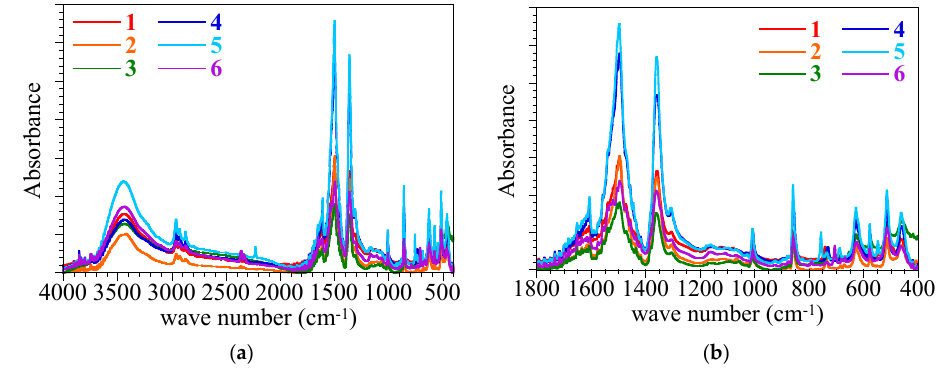
Figure 2. ( a ) Absorbance FT-IR spectra of compounds 1 – 6 in the range 4000–400 cm − 1 ( a ) and 1800–400 cm − 1 ( b ). Table 2. Main IR bands (cm − 1 ) and their assignments for compounds 1 – 6 .